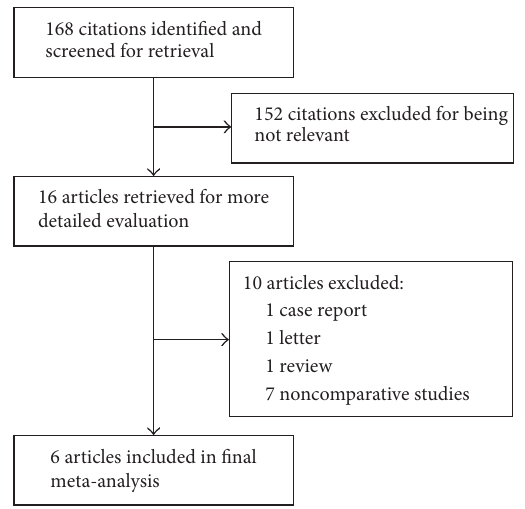
Figure 1: Flow chart of